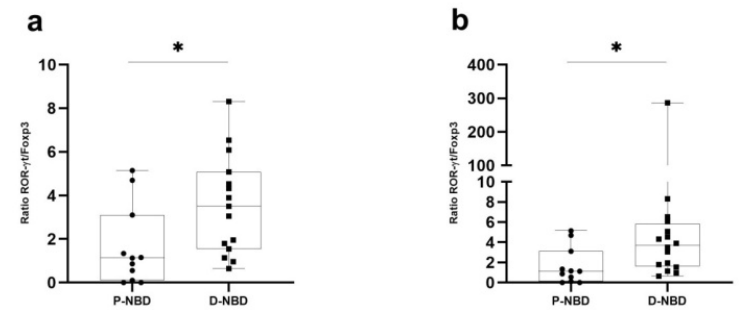
Figure 4. Boxplots representation of CSF ratios of the selected transcription factors: ( a ) Representative boxplots of RoR- γ t/ Foxp3 ratio in the CSF of P-NBD and D-NBD; ( b ) Representative boxplots T-bet/GATA3 ratio in the CSF of P-NBD and D-NBD. Statistical significance between the two groups was assessed using the Wilcoxon–Mann–Whitney test * p ≤ 0.05.